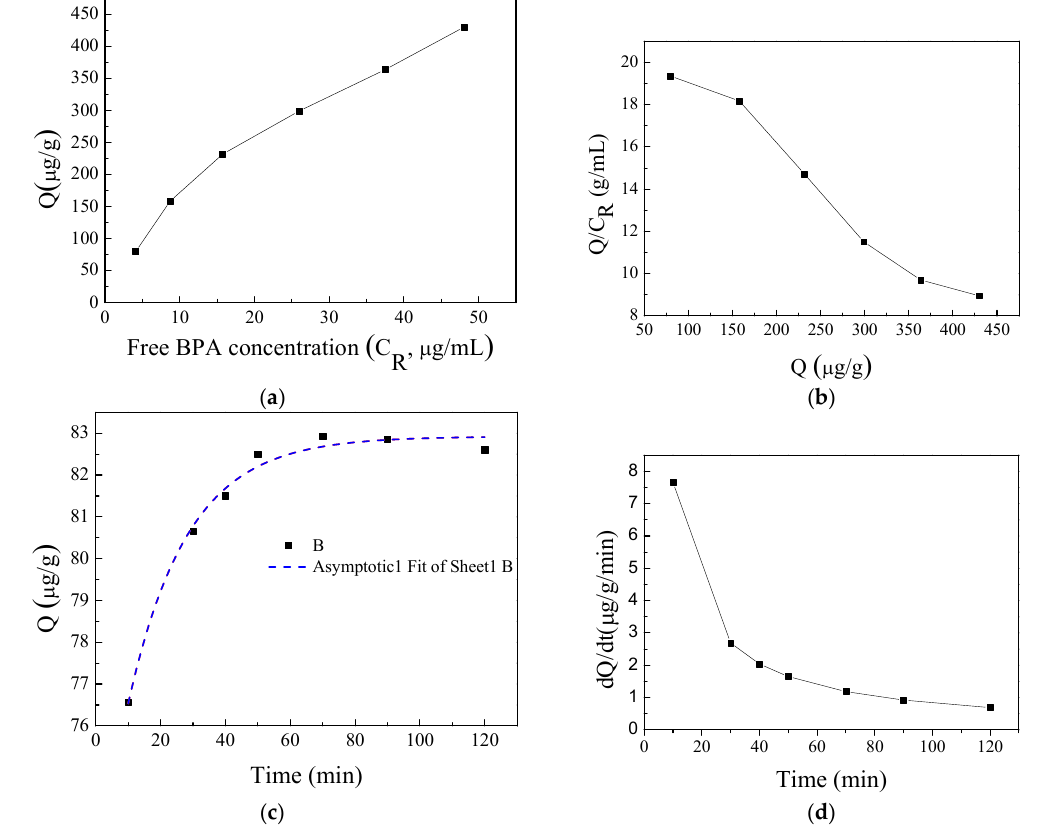
Figure 2. ( a ) The Langmuir adsorption isotherm curve of MIMS with equilibration time of 2 h; ( b ) Scatchard plot to estimate the binding nature of MIMS with equilibration time of 2 h; ( c ) kinetic adsorption curve for dynamic analysis of 10 μg mL −1 ; and ( d ) adsorption rate of MIMS with time changing.